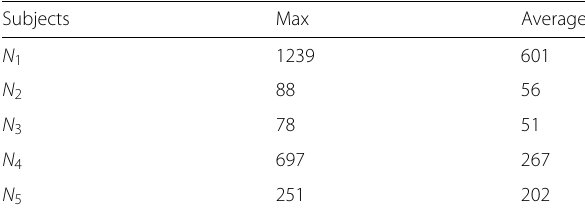
Table 6 Latency effects on T 2 : p 2 keystrokes delay beyond minimum offset (ms)